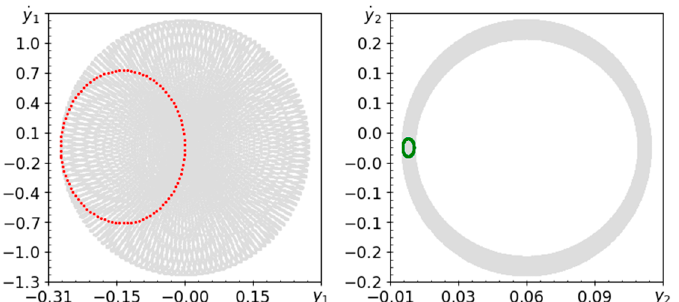
Figure 15. Phase planes (gray lines) and Poincaré maps (red and green dots) for A = 0.001, ω = 3.64.